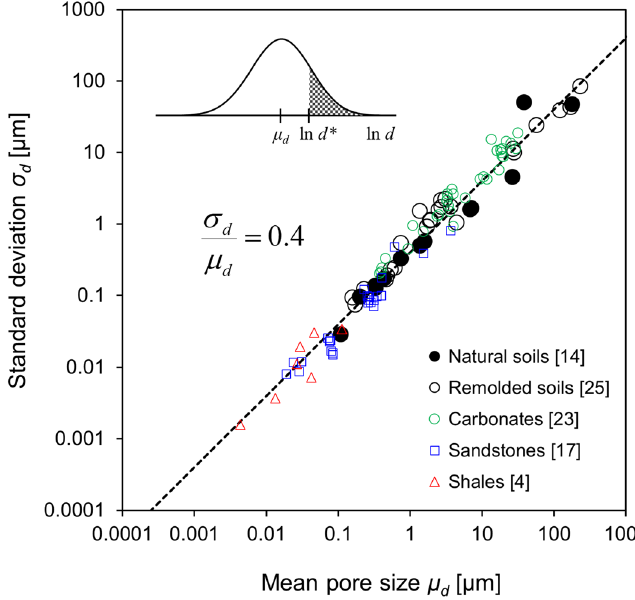
Figure 1. Pore size distribution for soils and rocks: standard deviation vs. mean. The number in square brackets indicates the number of datasets in each case (See Supplementary Table S2 and Figs. S2–S6). The hatched area in the inset indicates the probability of pores larger than a critical size d*